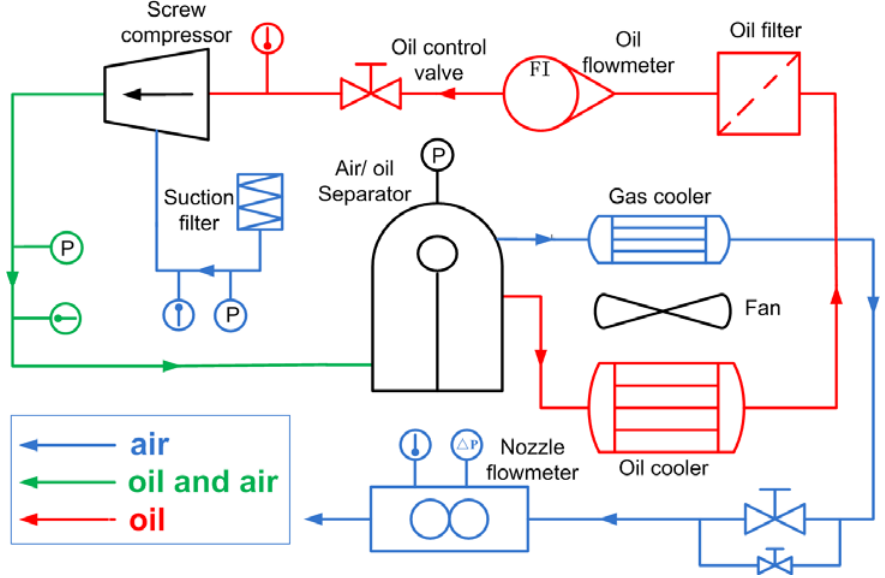
Figure 1. Schematic drawing of the compressor test system.